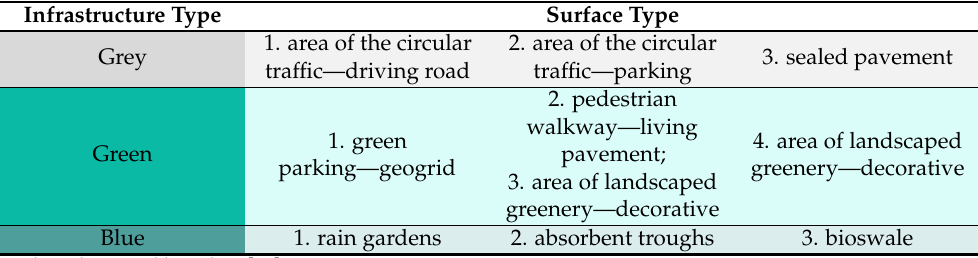
Table 1. Grey–green–blue infrastructure types used in design concept *.